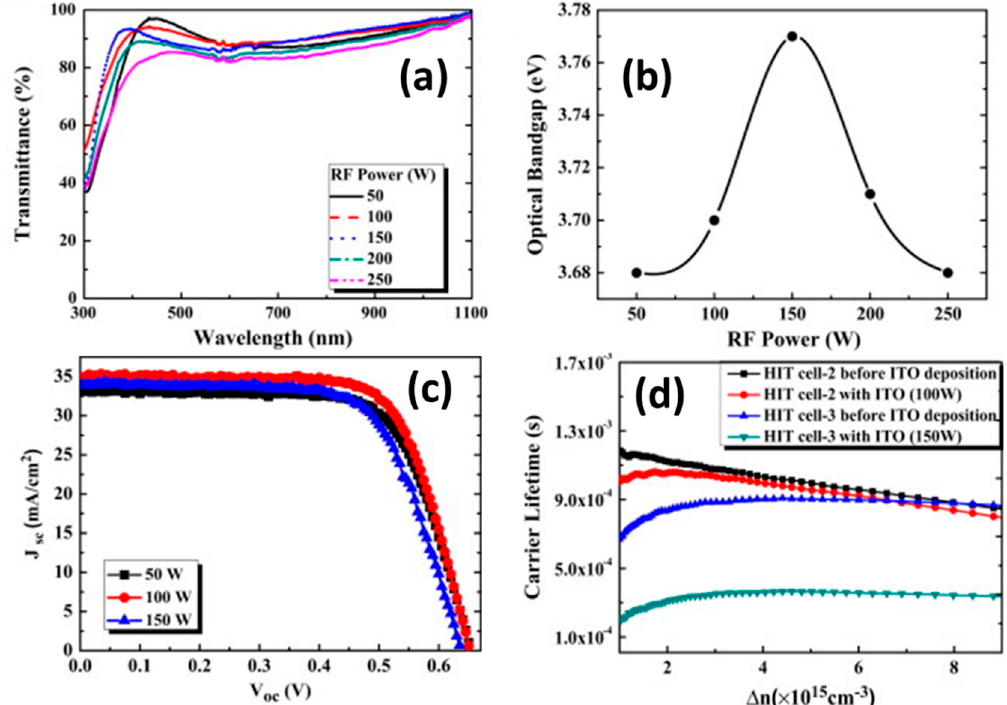
Figure 6. ( a ) Transmittance and ( b ) energy gap of ITO layers at different RF powers. ( c ) The J-V characteristics of SHJ PV cells for different RF powers. ( d ) Carrier lifetime for SHJ PV cell versus minority carrier density before and after deposition of ITO films for various RF powers. (Reprinted with permission from ref. [90]. Copyright form Elsevier order number 5492920513698.)